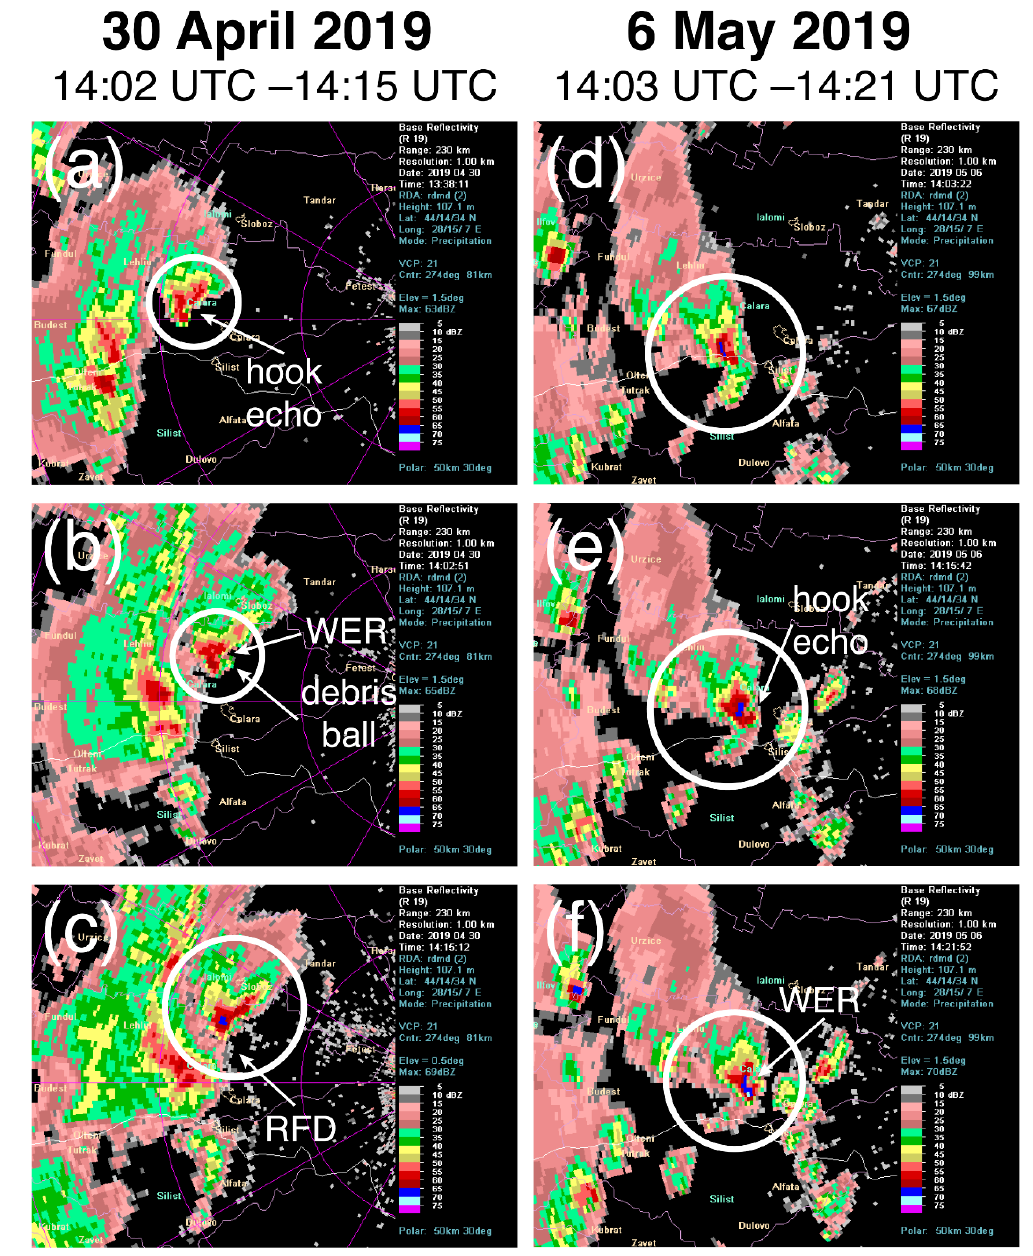
Figure 3. RDMD radar base reflectivity (in dBZ, lower right) of the tornadic supercell that occurred on 30 April 2019 ( left column ), and non-tornadic supercell that occurred on 6 May 2019 ( right column ). The white circle marks the position of the analyzed supercells during their maximum time evolution and the main radar signatures.